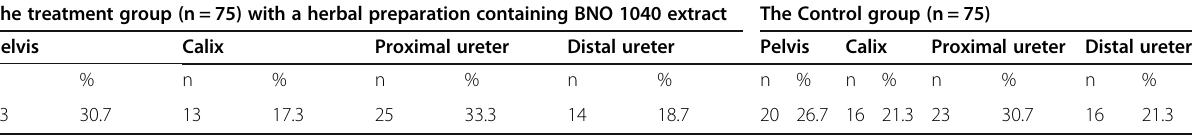
Table 4 distribution according to localization The treatment group (n = 75) with a herbal preparation containing BNO 1040 extract